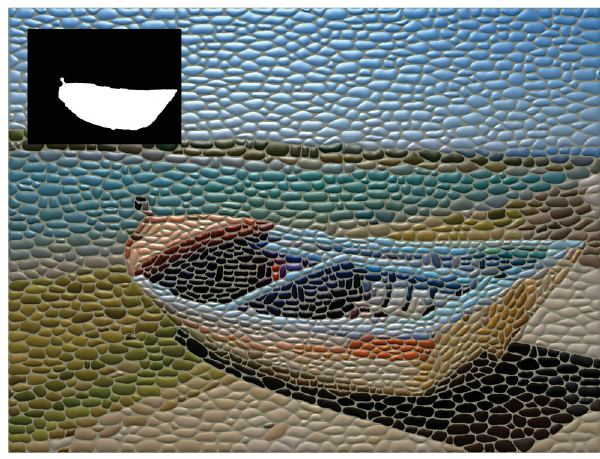
Fig. 15 Comparison. Left: Hausner’s method. Right: ours. Both results use 2000